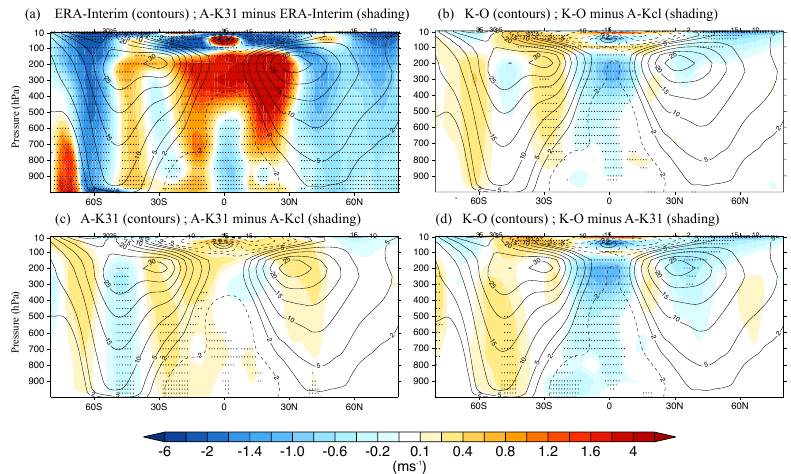
Figure 4. As in Fig. 3, but for the annual-mean zonal-mean zonal wind.